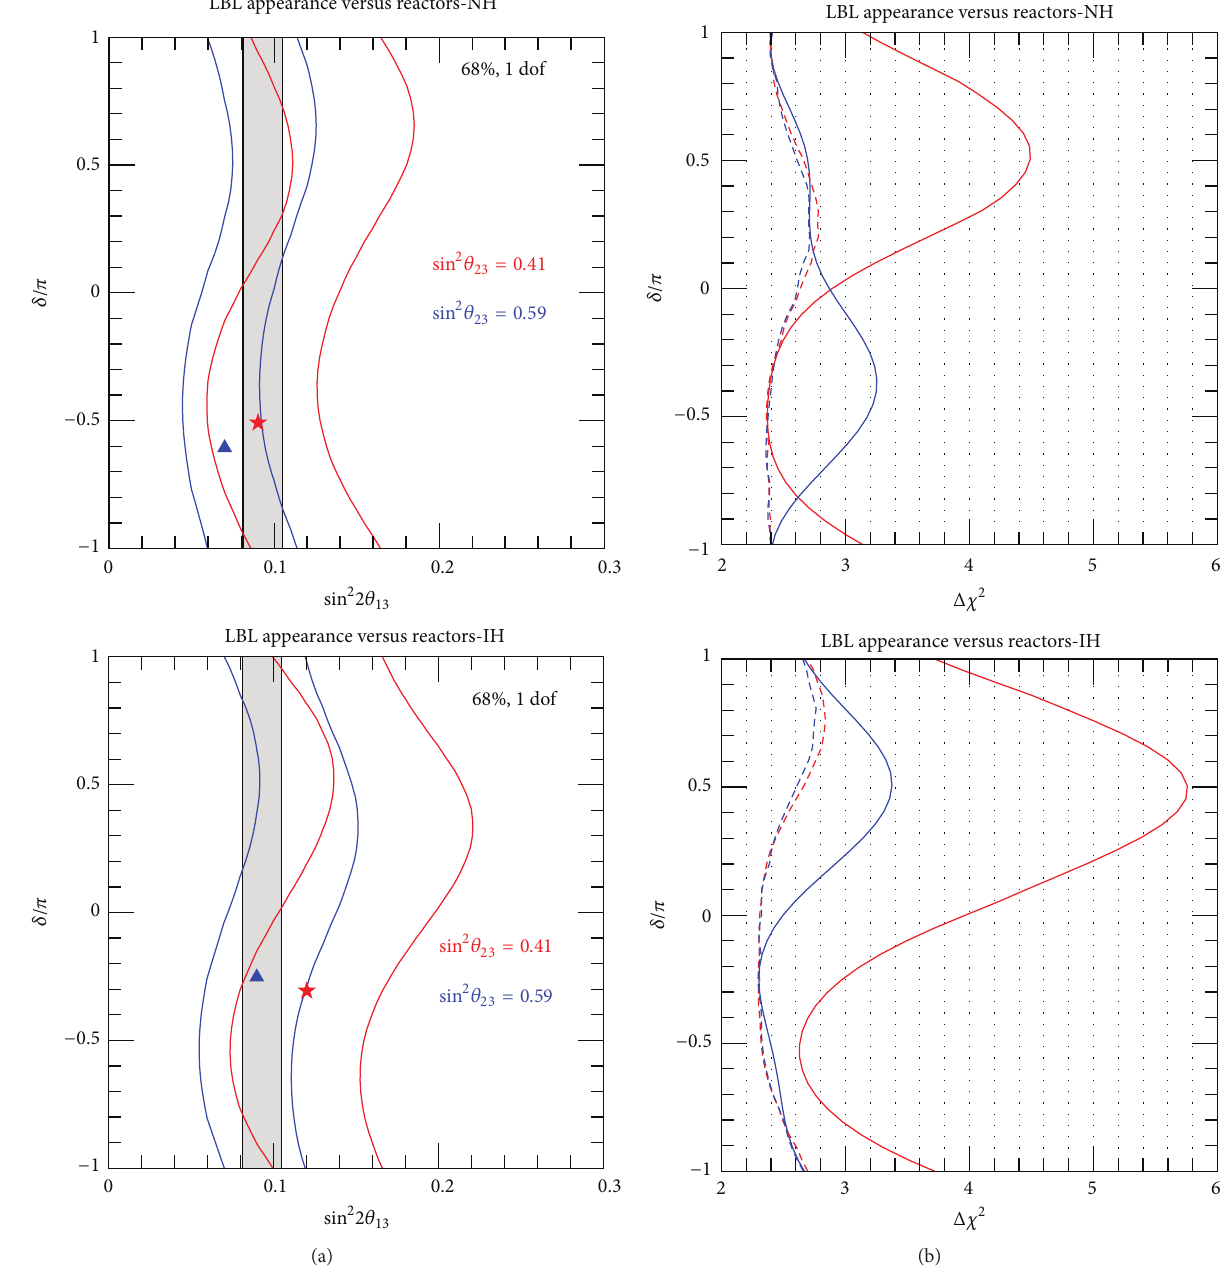
Figure 2: (a) Preferred regions in the sin 2 2𝜃 13 − 𝛿 plane. The contour curves correspond to beams T2K + MINOS, where sin 2 𝜃 23 is fixed to the two degenerate solutions in the 1st (red) and 2nd (blue) octant. The gray region corresponds to the 𝜃 13 determination from the reactors Double Chooz, Daya Bay, and RENO. (b) Δ𝜒 2 (𝛿) for beams (dashed) and beams+reactors (solid) with the same color coding as in the left panels. Upper (lower) panels are for NH